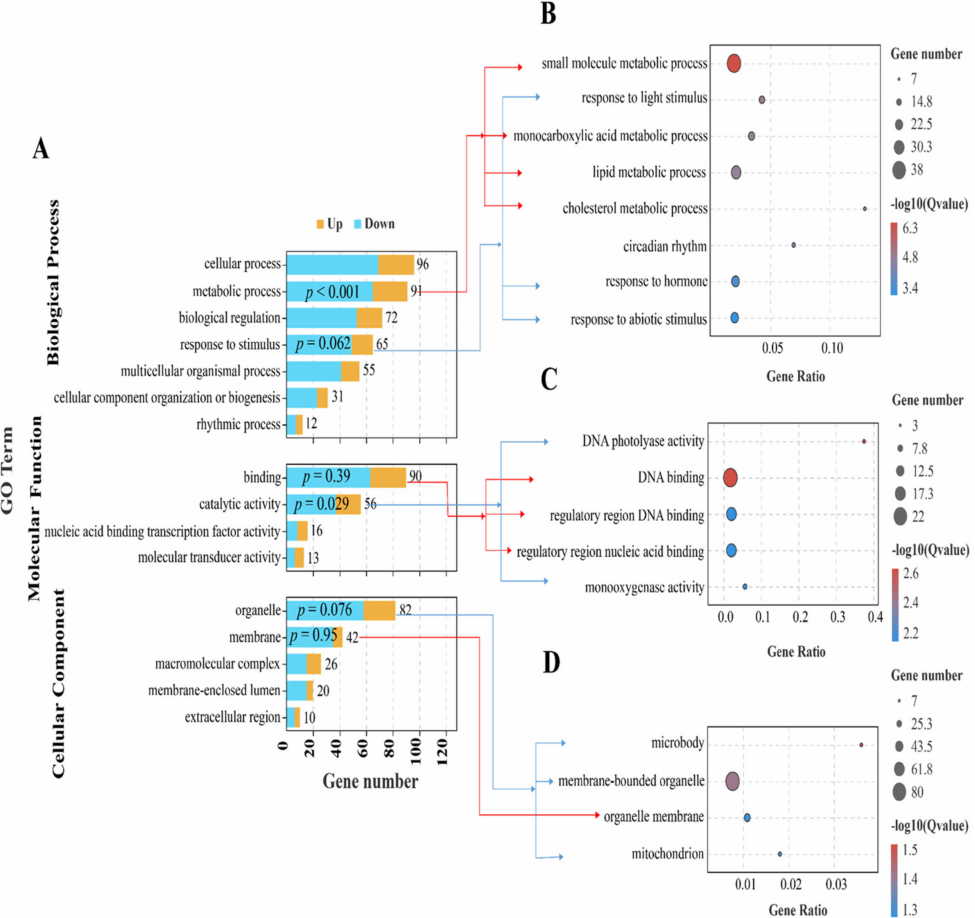
Figure 4. GO enrichment analysis for differently expressed genes (DEGs) in the livers of M. salmoides between the low-density group (LL) and the high-density group (HL). ( A ) GO enrichment terms pf DEGs in biological processes, molecular functions and cellular components. ( B ) Top 8 GO terms in the biological process category. ( C ) Top 5 GO terms in the molecular function category. ( D ) Top 4 GO terms in the cellular component category. P -values were corrected via the Benjamin– Hochberg